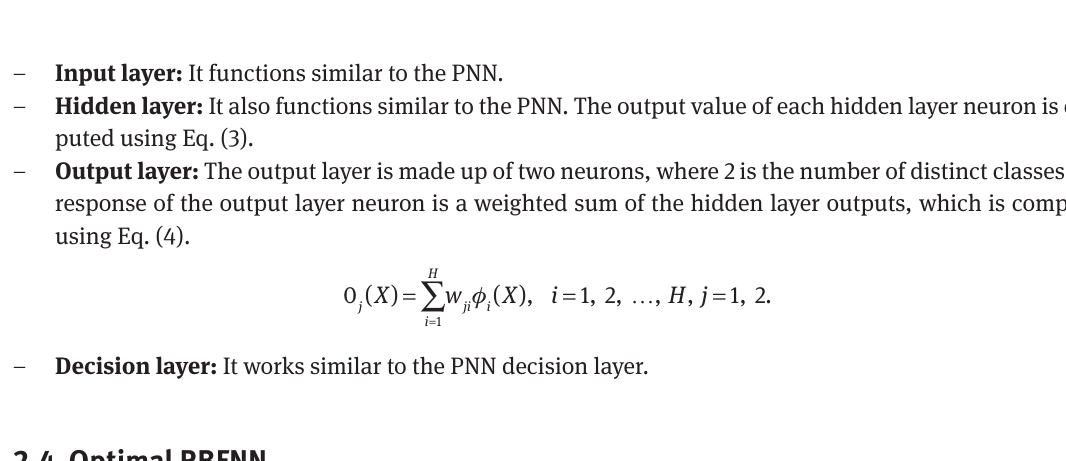
Figure 2: RBFNN model for classification